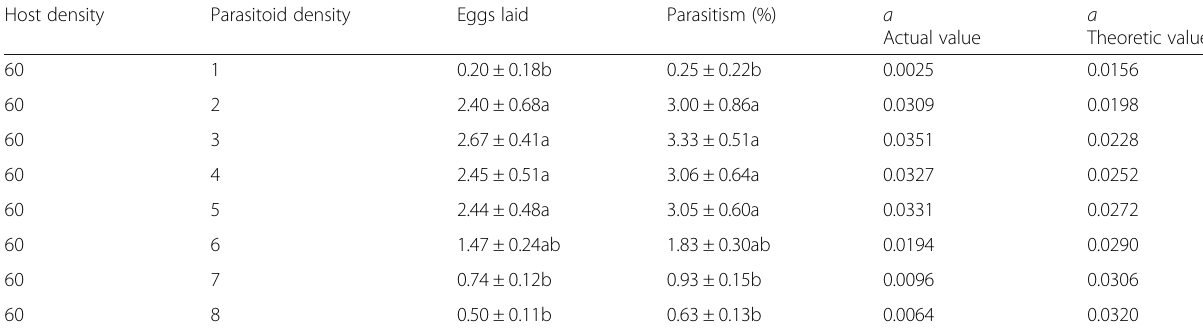
Table 4 Parasitic function of the different density Encarsia sophia on Bemisia tabaci nymph (M ± SE)